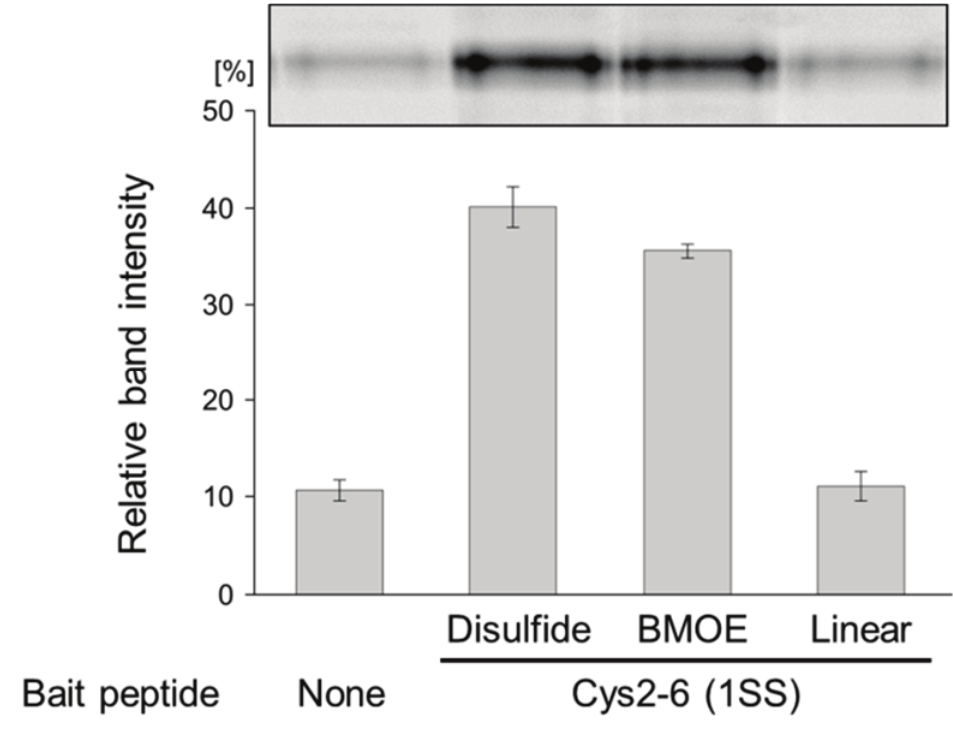
Figure 5. Evaluation of the interaction between the chemically cross-linked Cys2-6 peptide and sIL-6R. Cys2-6 with a disulfide bridge, BMOE, or treated with iodoacetamide (Linear) were prepared, and then sIL-6R was pulled down. The pulled-down sIL-6R was visualized by SDS-PAGE (Upper) and the relative band intensities of pulled-down sIL-6R are shown (Lower). Experiments were repeated 3 times. Error bars = standard